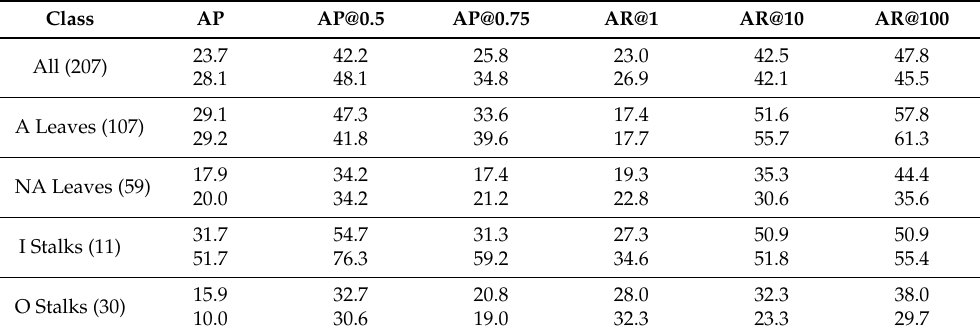
Table 6. Results on a test set with inconsistent annotations from the three annotators. For each metric, results from two models are shown trained on different sets of data, the upper being trained on the inconsistent dataset and the lower being trained on the consistent dataset.